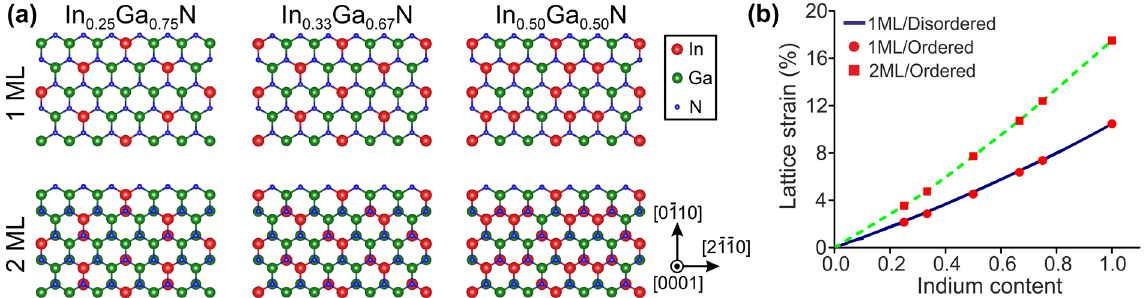
Figure 4. ( a ) Schematic illustrations in plan-view (i.e., along [0001]) of the ordered 1 ML and 2 ML QW structures up to the indium content of x In = 50%. (The higher compositions of x In = 67% and 75% can be obtained by the interchange of indium with gallium atoms.) ( b ) Lattice strain along [0001], ε content of the QW, x In , shown for the 1 ML ordered and disordered atomic distributions, as well as for the 2 ML ordered.